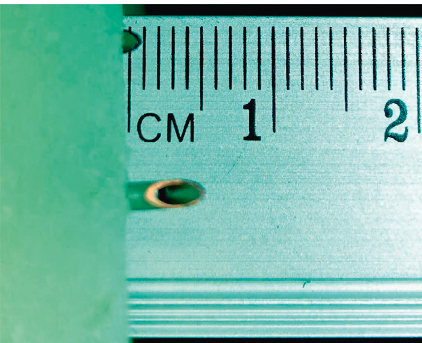
simulator to show the method of measuring the extent of the epidural needle in the epidural space. In the study, each mea- surement was performed after each individual test by an inde- pendent